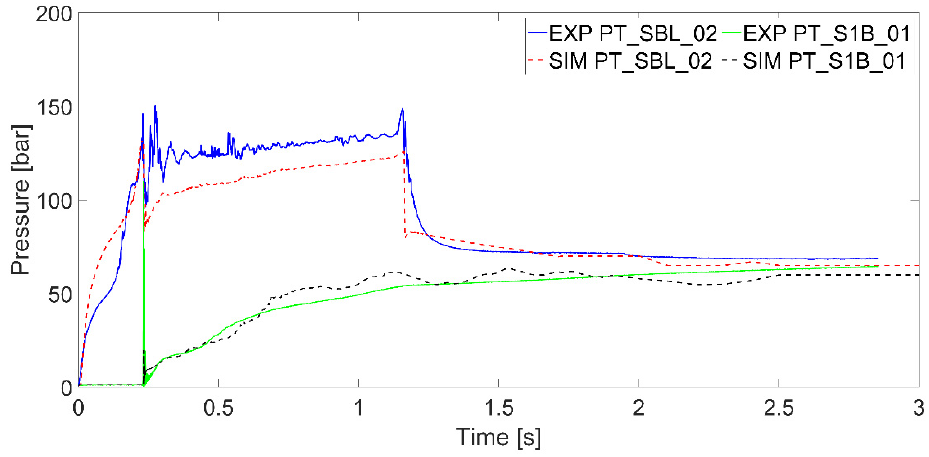
Figure 14. Standalone simulation—pressure evolution in the injection line and in S1B, compared with experimental data (PT).